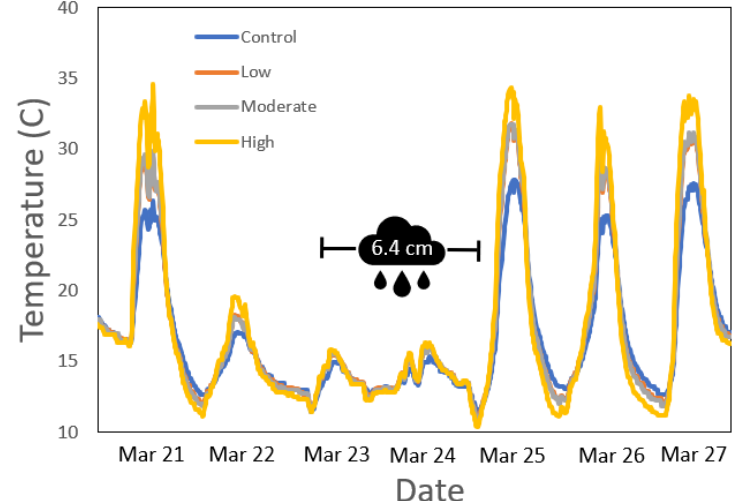
Figure 3. iButton temperature readouts for each of the 4 experimental treatments (unburned control; level 1 = low severity; level 2 = moderate severity; level 3 = high severity) during a portion of the study period. A significant multi-day rain event occurred between 3 / 23 and 3 / 25. See supplemental table for the data from the entire study period, including Analysis of Variance (ANOVA) and pairwise comparison results.